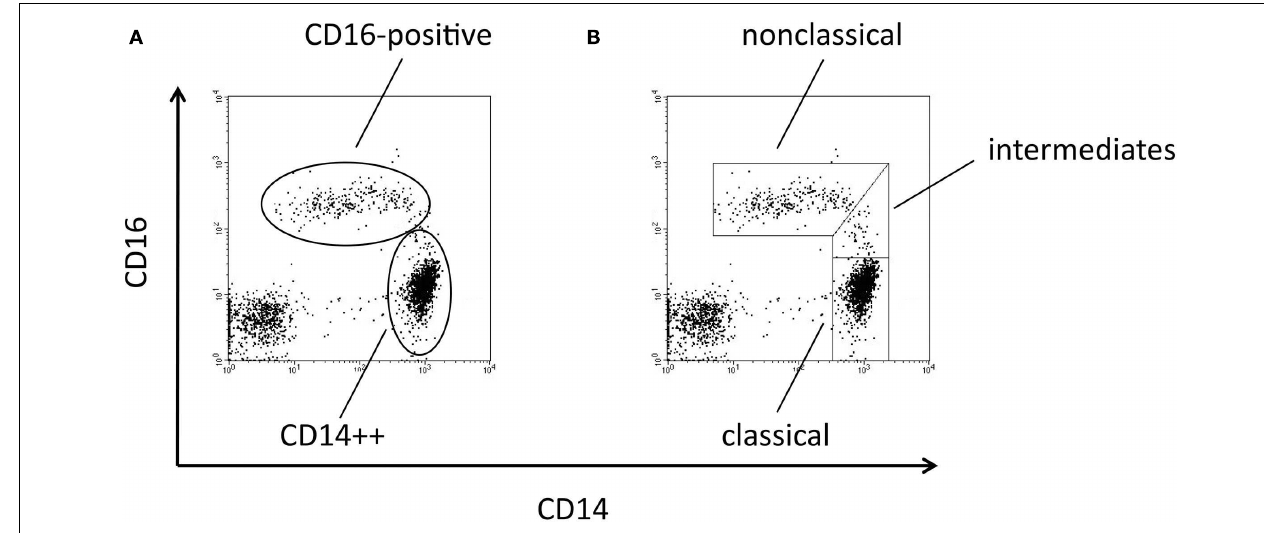
FIGURE 1 | Dot blot histograms from monocyte subpopulations using CD14 and CD16 markers. In (A) the conventional gating strategy is shown, representing CD14 ++ and CD16-positive populations. In (B) a refined gating approach is given, which defines the intermediate monocytes in addition to classical and non-classical monocytes.